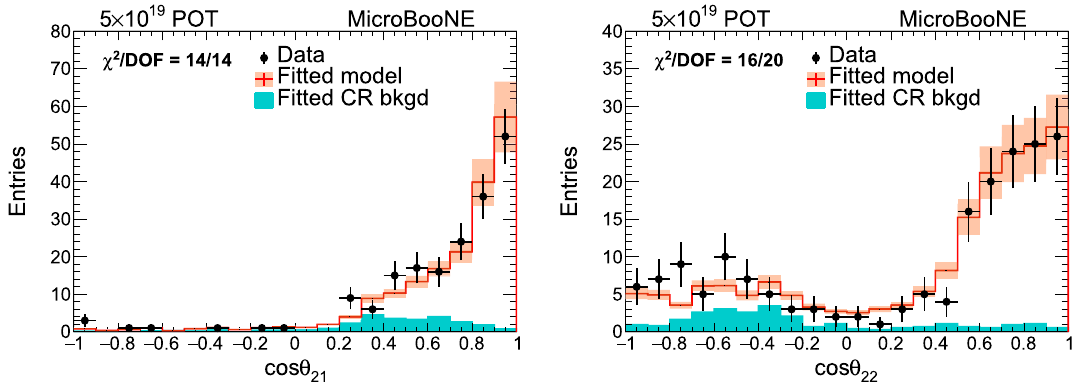
Fig. 18 Multiplicity = 2 cos θ distribution for candidate muon (left); for second track of the event (right) using GENIE default model from neutrino-enriched sample for data and GENIE default MC